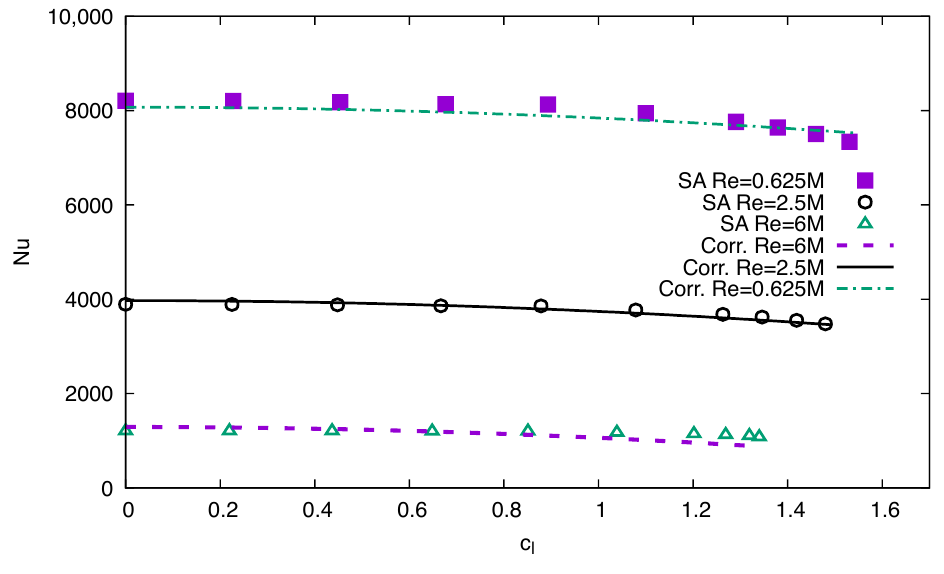
Figure 11. Nu as a function of c l : comparison between CFD results and correlation for the smooth NACA 0012 airfoil.